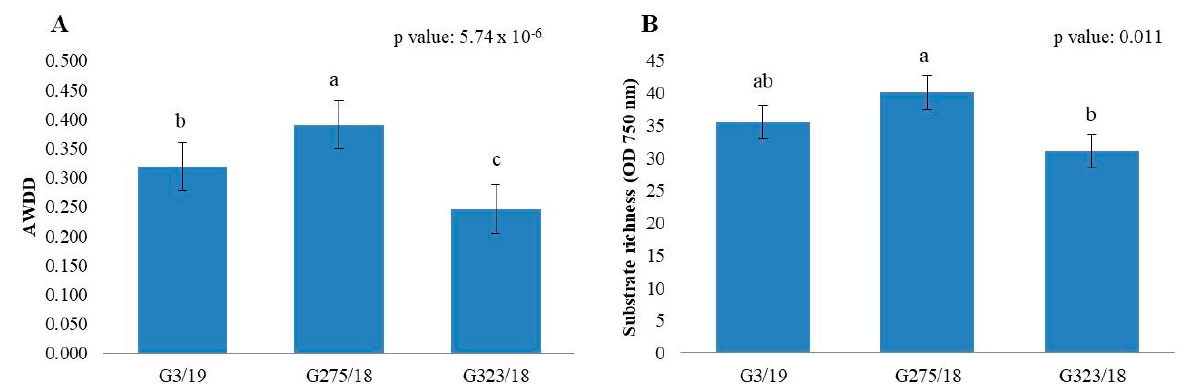
Figure 5. AWDD ( A ) and substance richness ( B ) indices for the three different strains of Botrytis cinerea . Each value is represented with the standard error. The lowercase letters represent the results obtained after applying the post hoc Wilcox test (Tables S19–S23).